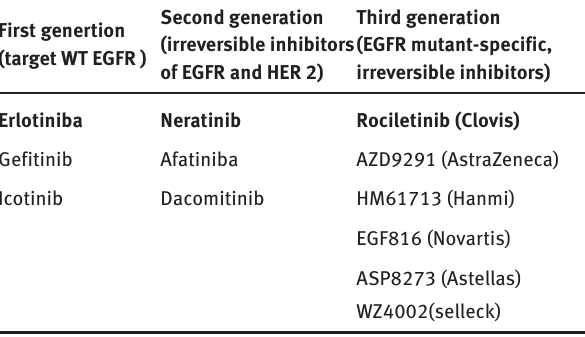
Table 1: Representative EGFR-TKIs currently in use or development. edited from